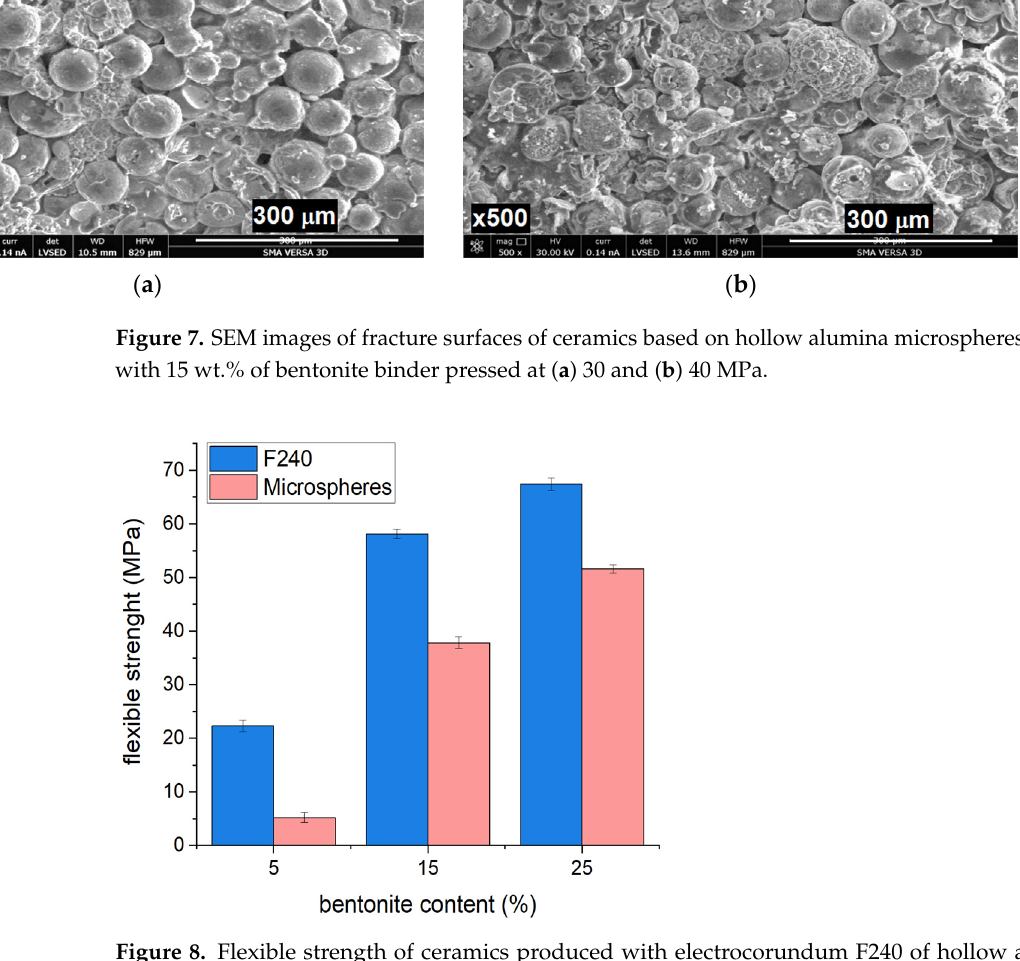
Figure 8. Flexible strength of ceramics produced with electrocorundum F240 of hollow alumina microspheres as fillers vs. bentonite binder content in them.